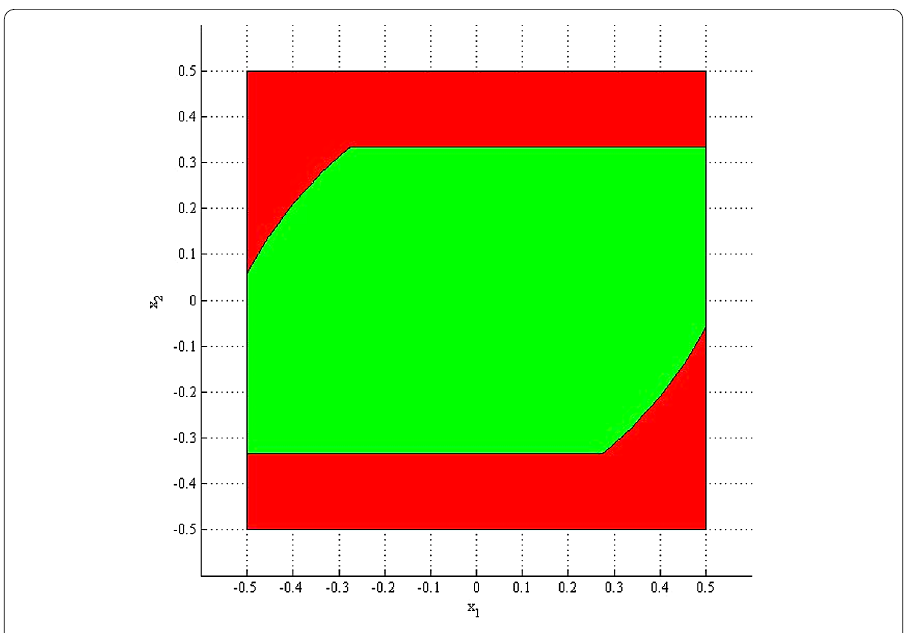
Figure 1 Viability constraint (5.3) (red) and the corresponding viability kernel (green) for (5.1) by using Algorithm